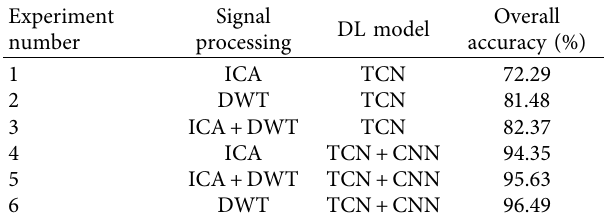
Table 2: Classification accuracy of distinct